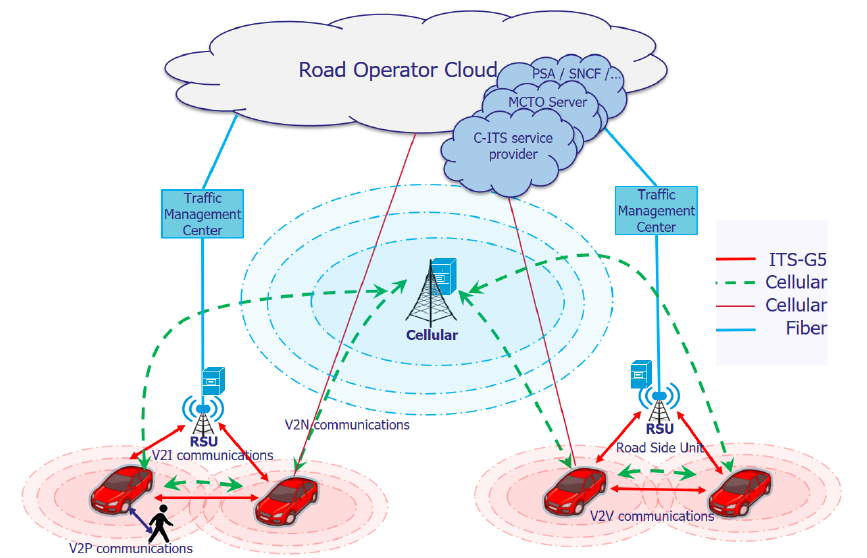
Figure 1. Vehicular